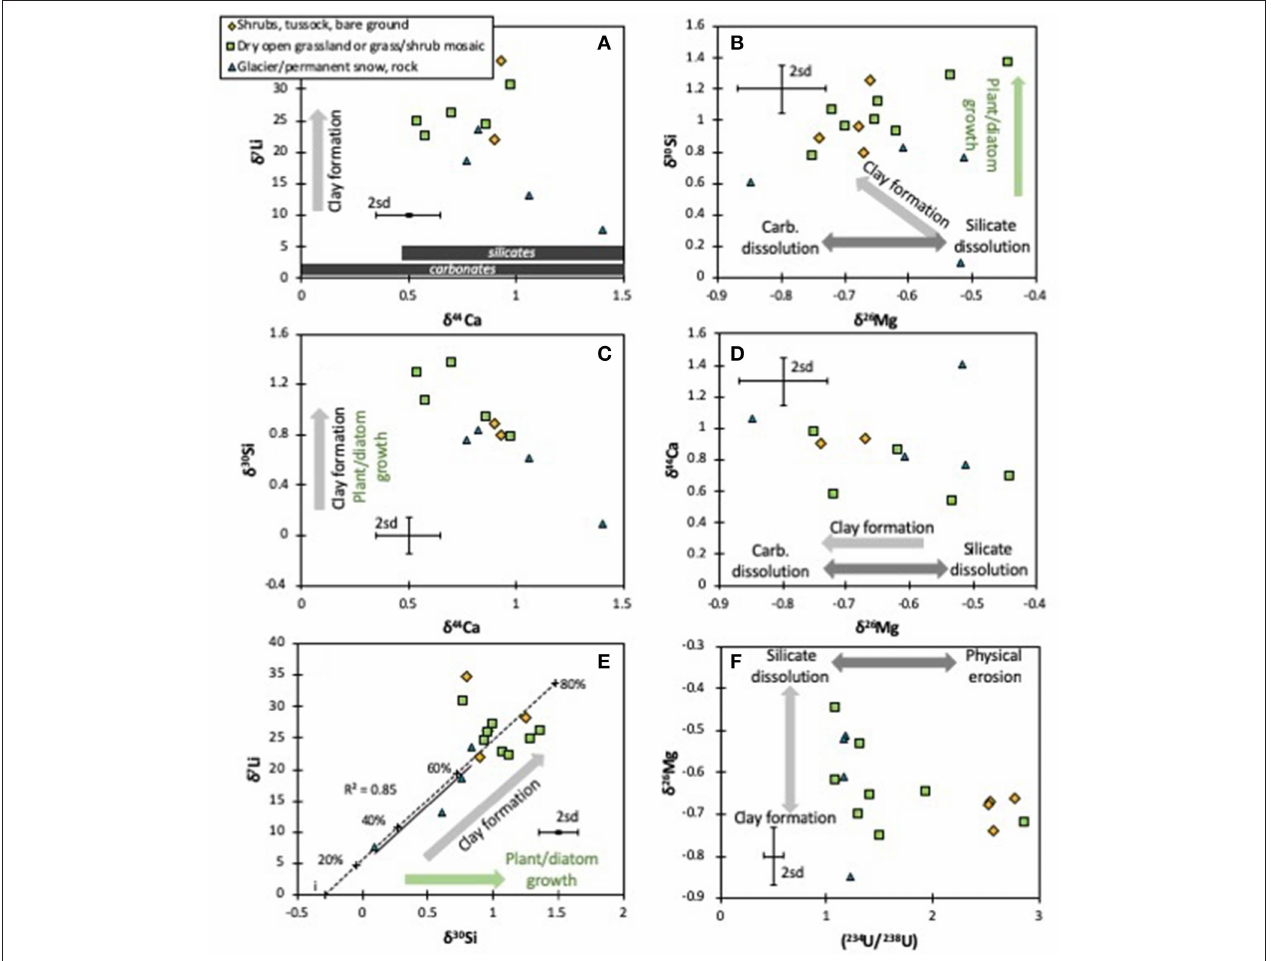
FIGURE 4 | Cross-plots between the isotope systems analyzed in this and other studies for the different vegetation types (Robinson et al., 2004; Pogge von Strandmann and Henderson, 2015): isotopes of Li vs. Ca (A) , Si vs. Mg (B) , Si vs. Ca (C) , Ca vs. Mg (D) , Li vs. Si (E) and Mg vs. U (F) . The arrows represent fractionation directions by different weathering and plant formation processes. For Ca isotopes (A) , the range of carbonate and silicate rocks is shown. The error bars represent the long-term 2sd external uncertainty.